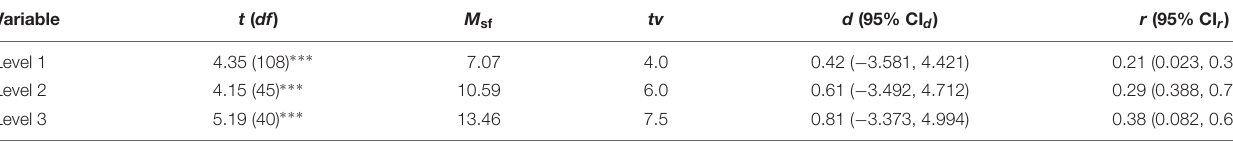
TABLE 1 | One sample t -test for scholar maladjustment by level of studies. Variable